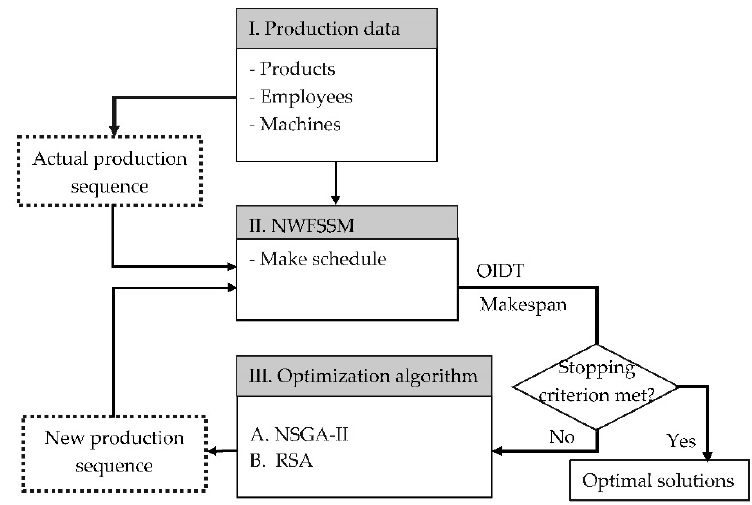
Figure 2. Schematic flow diagram of bakery production optimization.